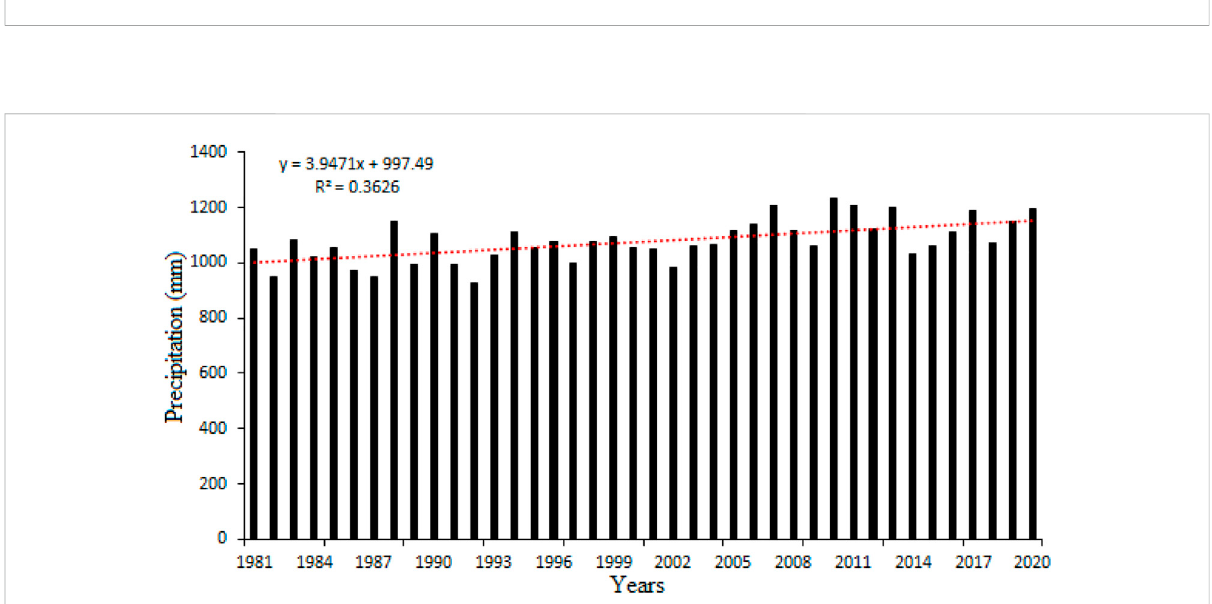
FIGURE 7 ARIMA Forecasting for time series fall mean precipitation for the study period.